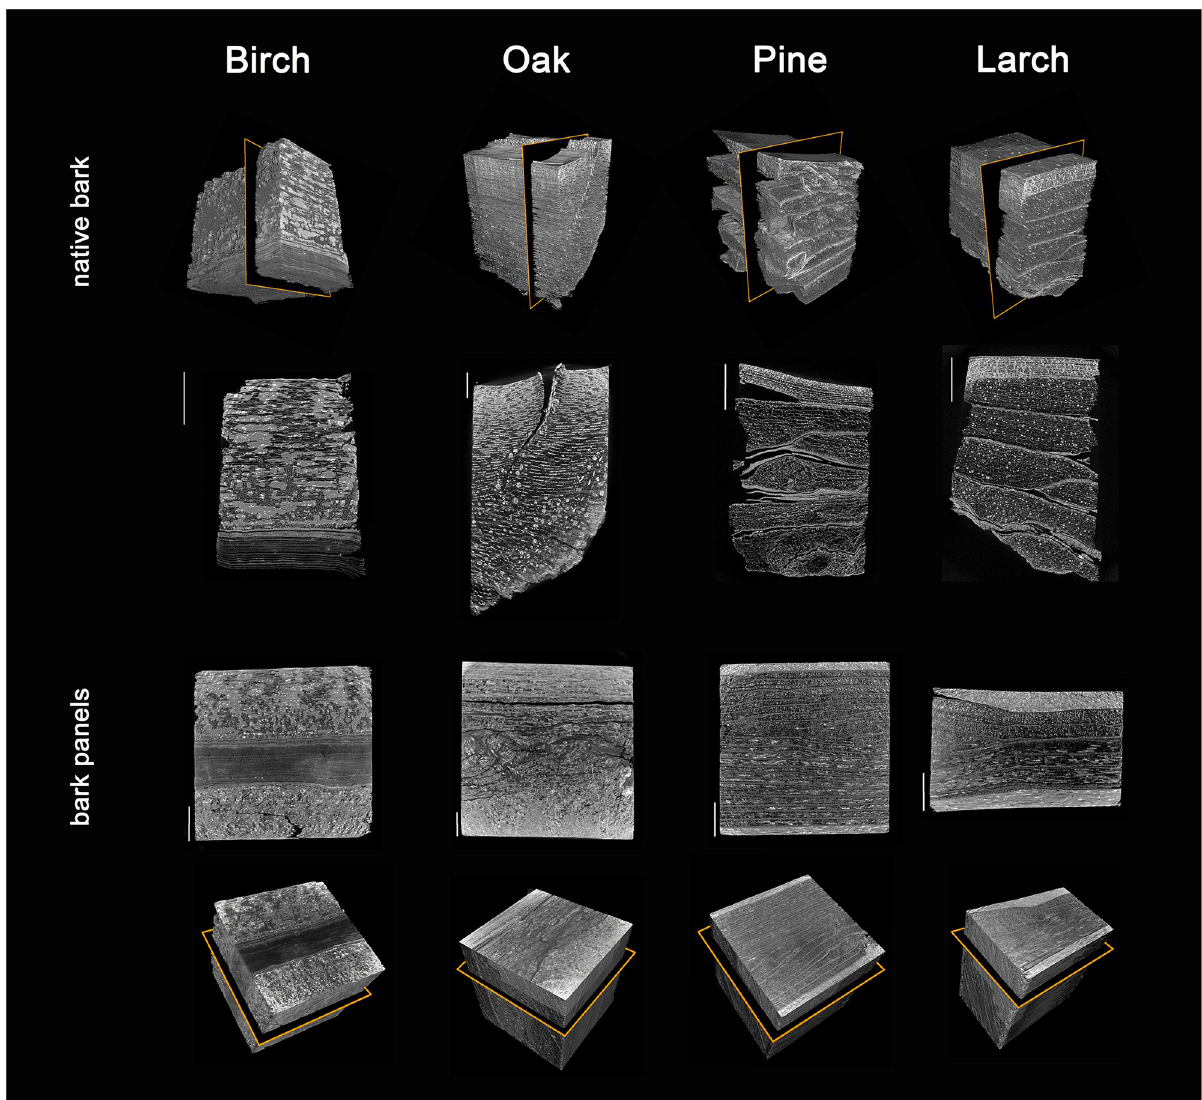
Fig 3. μ CT scans of native bark pieces and compressed bark. Black slices in rectangular volumes indicate the virtual cutting directions of the slices next to the volumes. Bars 2 mm.